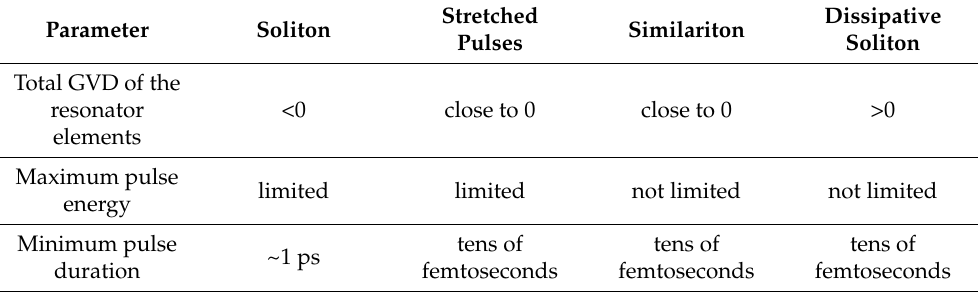
Table 2. Comparison of the main characteristics of various generation modes in fiber USP